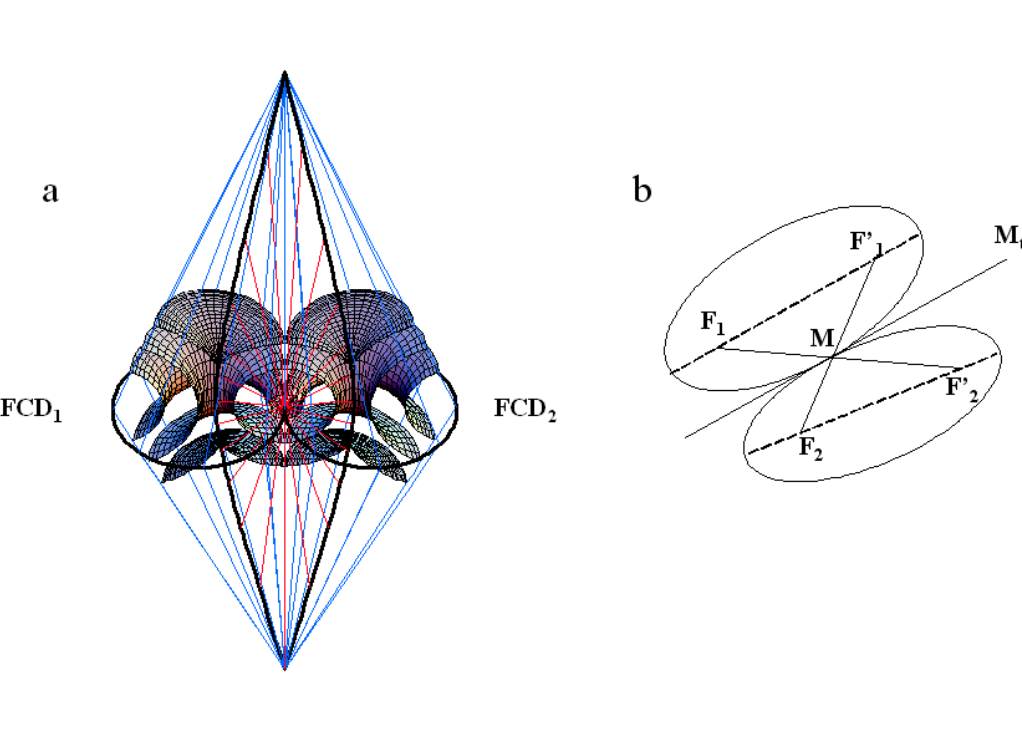
Figure 5. Illustration of the law of corresponding cones ( l.c.c ) for two tangent ellipses and their confocal hyperbolae ; (a): 3D representation: the two cones which lie on the two ellipses (blue cones) have one common generatrix; likewise for the two cones, which lie on the two hyperbolae (red cones); adapted from [14]; (b): 2D representation: the line joining the visible focus F of one ellipse to the invisible focus (not physical) of the other F 0 1 exactly through the tangential point M between the two ellipses; adapted from